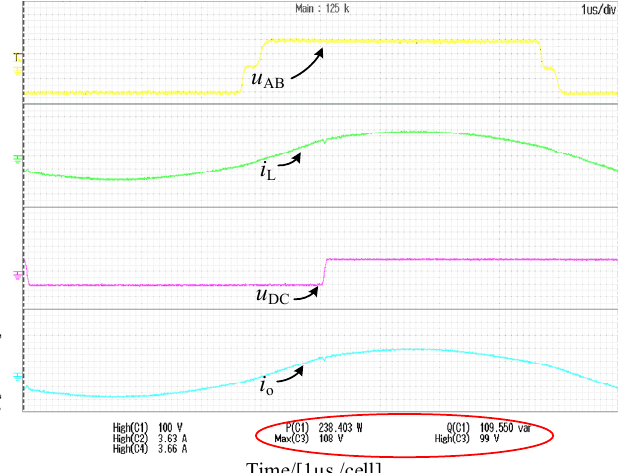
Figure 37. φ AD = 40 ° and φ AB = 171 ° experimental waveforms without reactive power optimization.